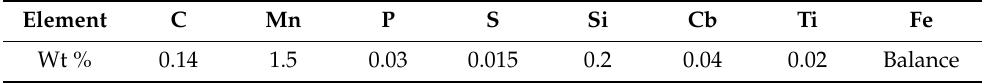
Table 2. Main components for the coatings deposited on the surface of the API steel. PSC1: